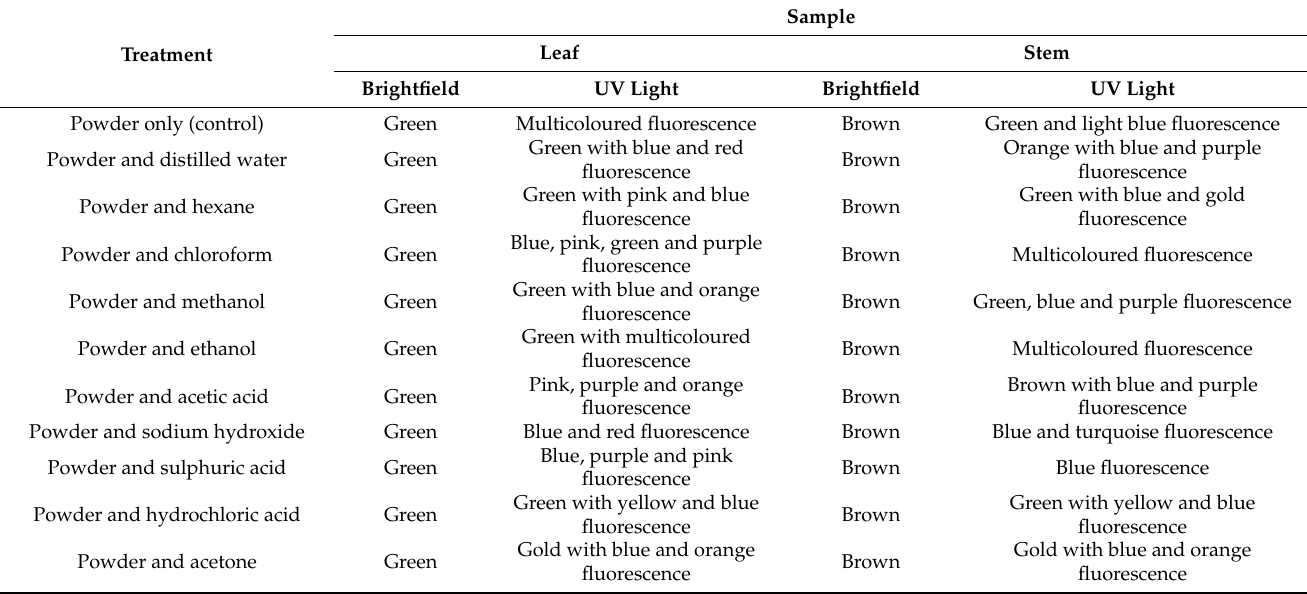
Table 5. Fluorescence analyses of powdered leaf and stem samples of Combretum molle